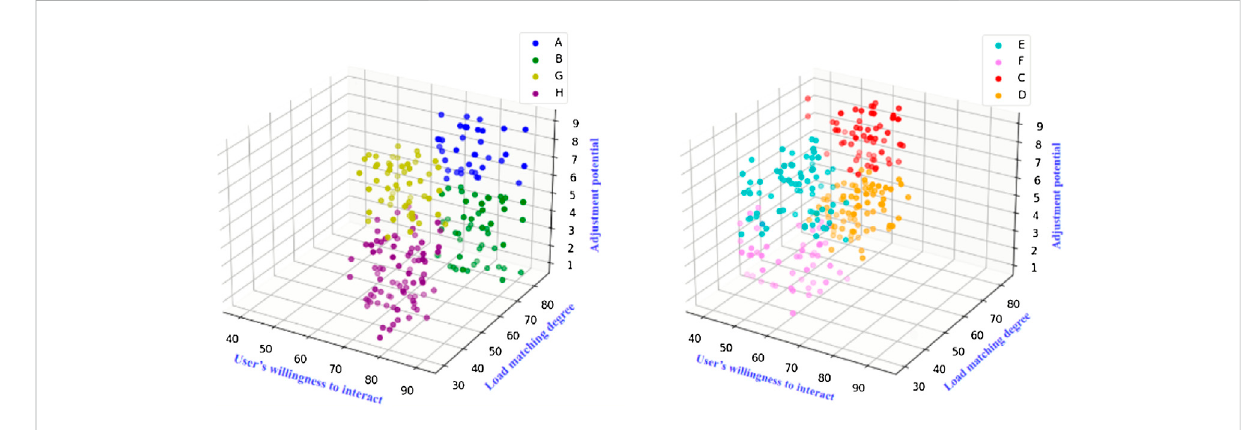
FIGURE 7 Grouping results of 504